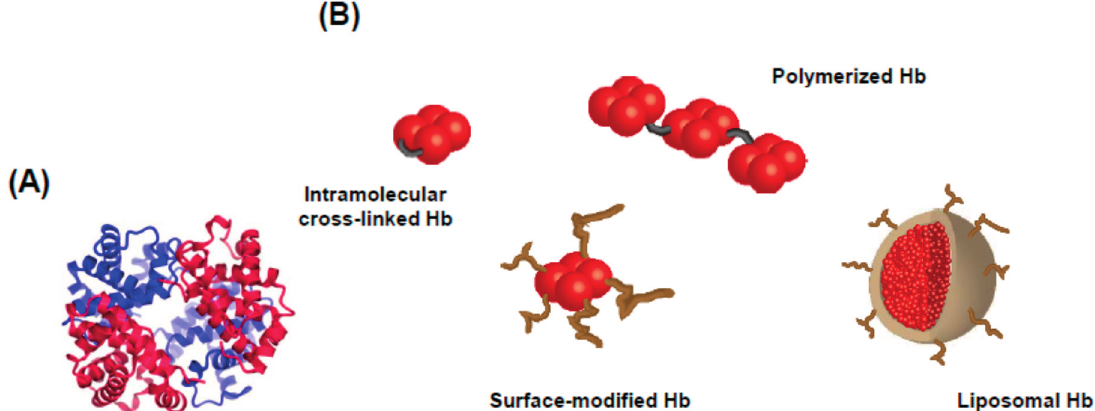
Figure 5. ( A ) Crystal structure of deoxy hemoglobin at a resolution of 1.74 Å. ( B ) Schematic representation of acellular type and cellular type of hemoglobin-based oxygen